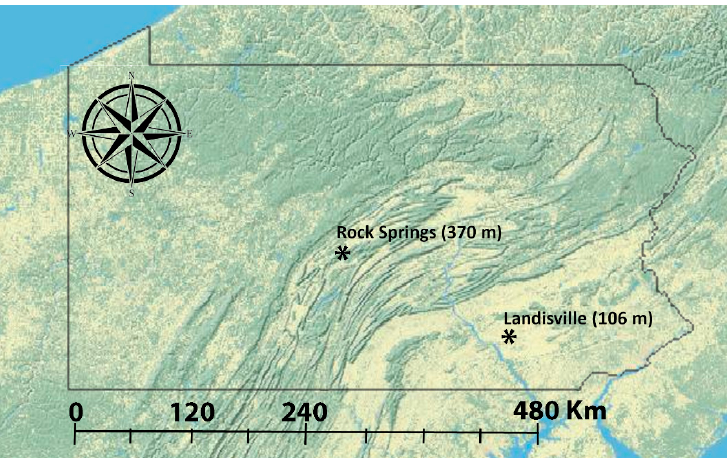
Figure 1. A topographic map with state of Pennsylvania outlined and the collection sites in Landisville (LV) and Rock Springs (RS), marked. Linear distance between collection sites is approximately 150 km. Elevation of Landisville and Rock Springs are 106 m and 370 m above mean sea level, respectively. respectively. Topological map was obtained from the US Geological Survey (https: // ngmdb.usgs.gov / topoview / viewer / ; accessed on 05 June